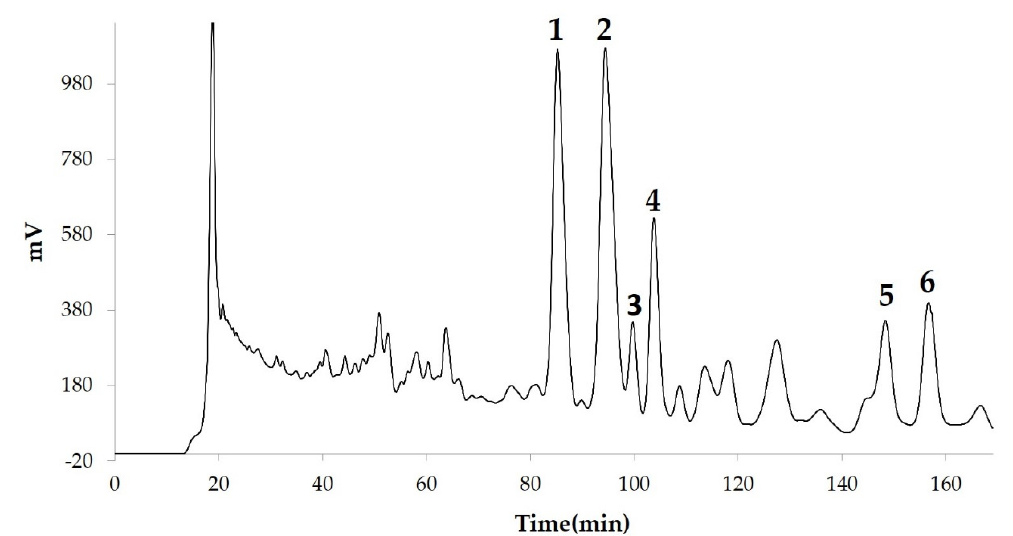
Figure 2. Compounds separated by high-performance liquid chromatography (HPLC) from 90% methanol fraction.